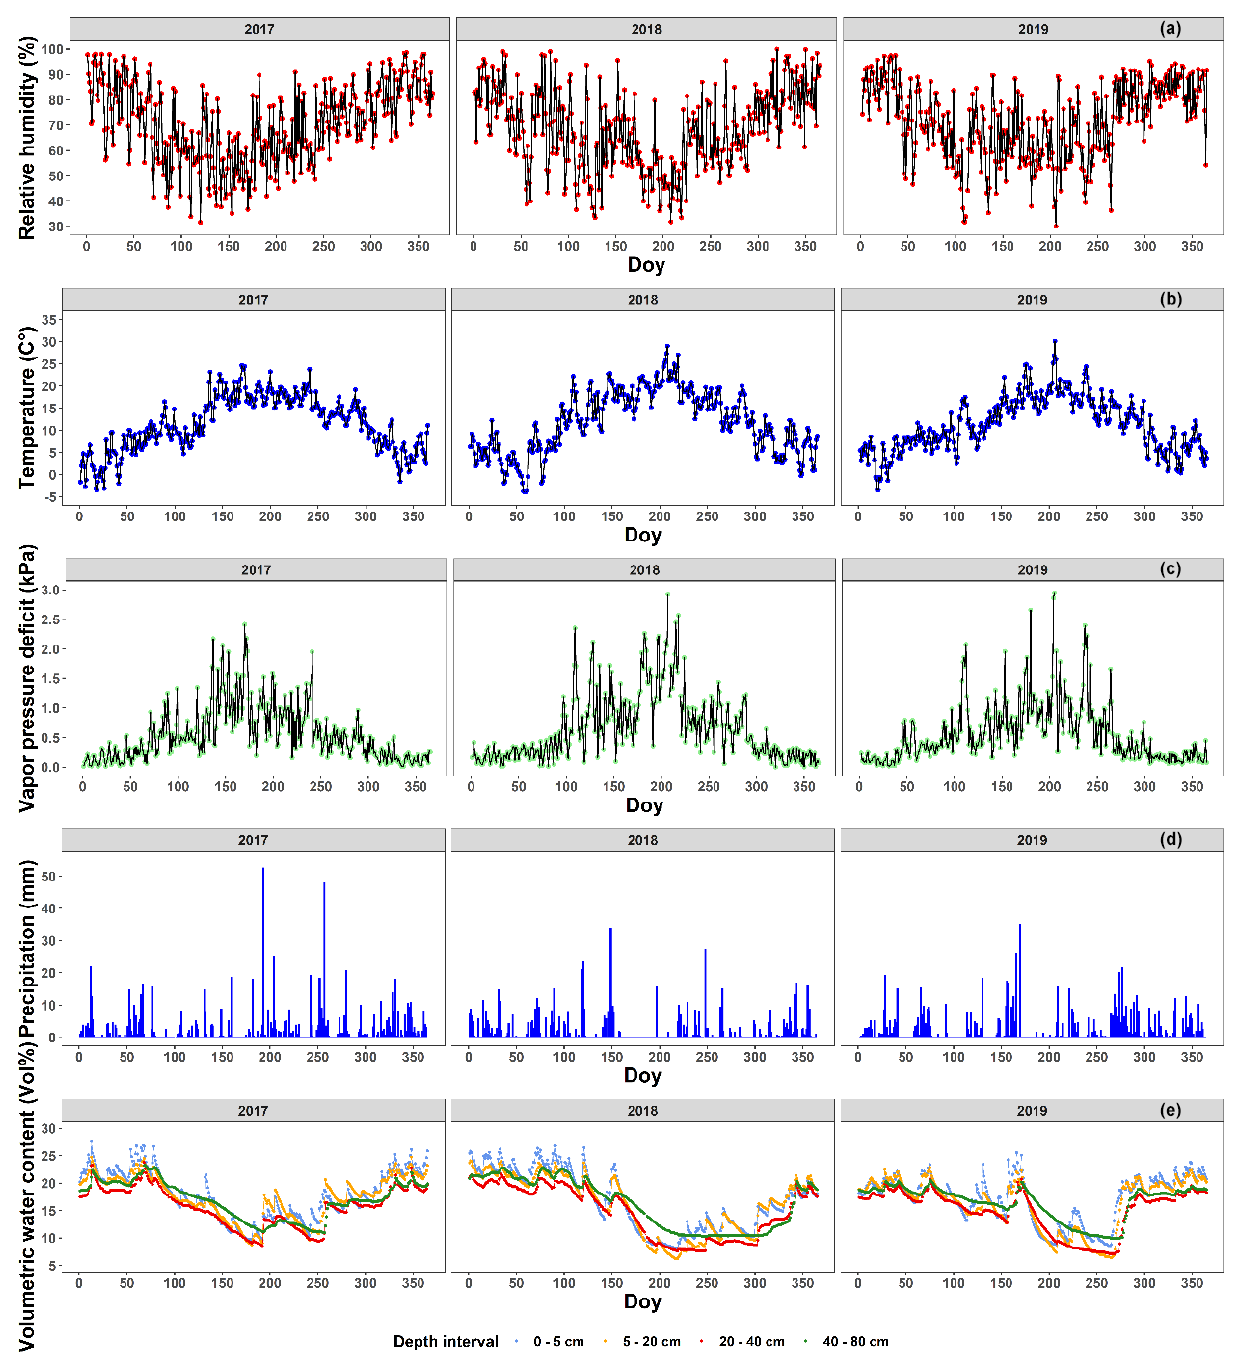
Figure 2. The meteorological conditions near the Klein Schietveld and Park of Brasschaat. The line plots represent the daily average relative humidity (%; red), temperature ( ◦ C; blue) and vapor pressure deficit (kPa; green). The bar plots represent the daily precipitation (mm; light blue). The volumetric soil water content (Vol%) at depth intervals of 0–5, 5–20, 20–40 and 40–80cm is presented as line plots in cornflower blue, orange, red and green, respectively. The relative humidity, temperature, vapor pressure deficit and precipitation data were measured every half hour and provided by the Flemish Institute for Nature and Forest (INBO), the Integrated Carbon Observation System (ICOS), and the Royal Netherlands Meteorological Institute (KNMI). The vapor pressure deficit (kPa) was calculated using the formulas of Buck (1981) using data of the relative humidity and air temperature between 07:00 and 19:00CET. The volumetric soil water content data were first measured every 6h, but after 3 July 2018 measurements were made every hour. The volumetric soil water content data were provided courtesy of